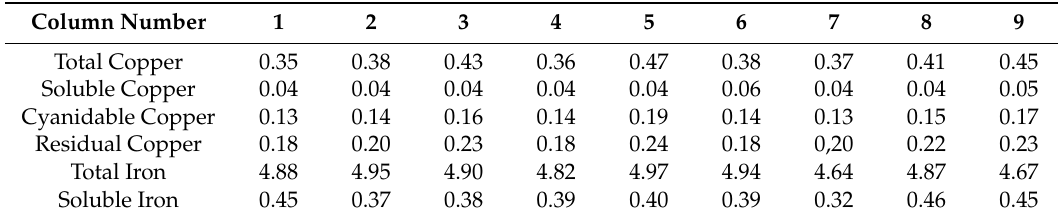
* See Table 4 for conditions of agglomeration in each column.